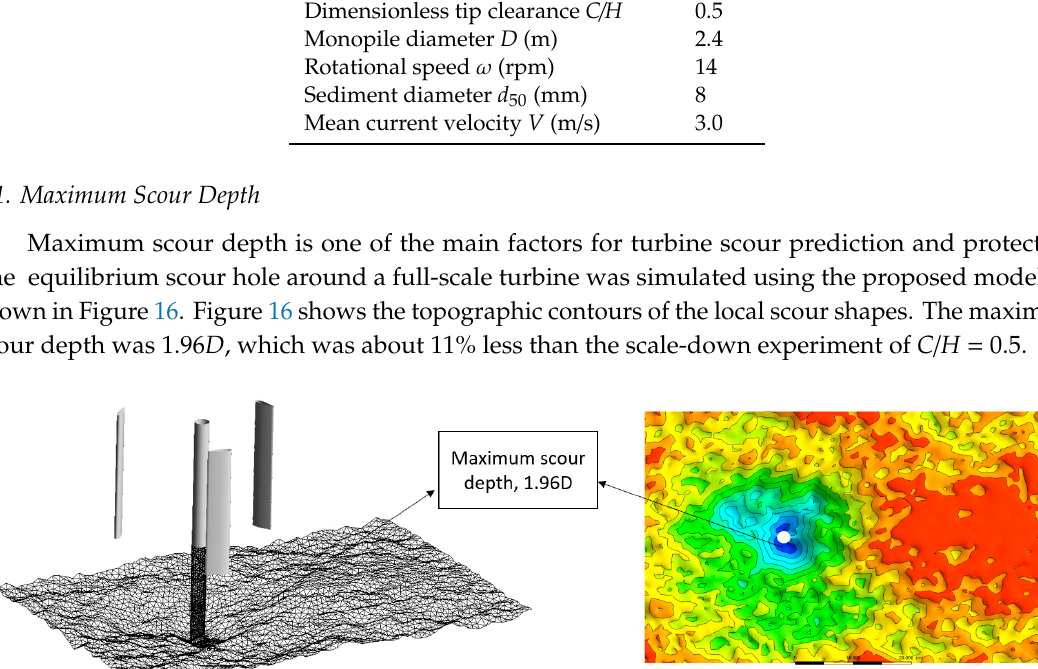
Table 5. Numerical setup of full-scale turbine model.